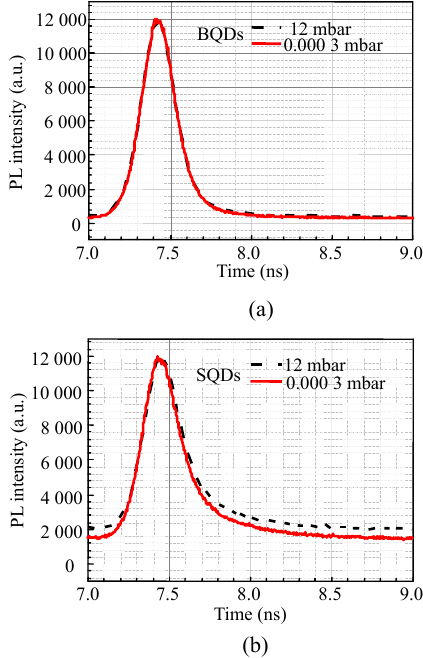
Fig. 6 TRPL of: (a) BQDs and (b) SQDs with different